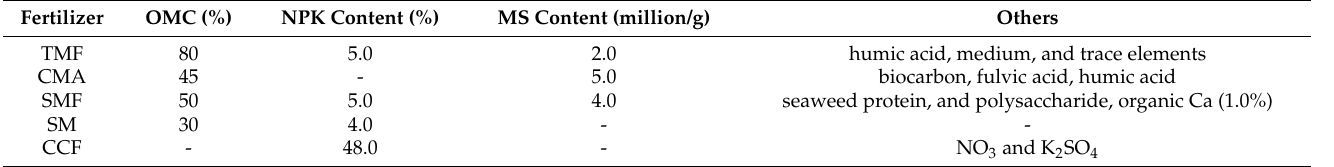
Table 1. The composition of each fertilizer used in this study.